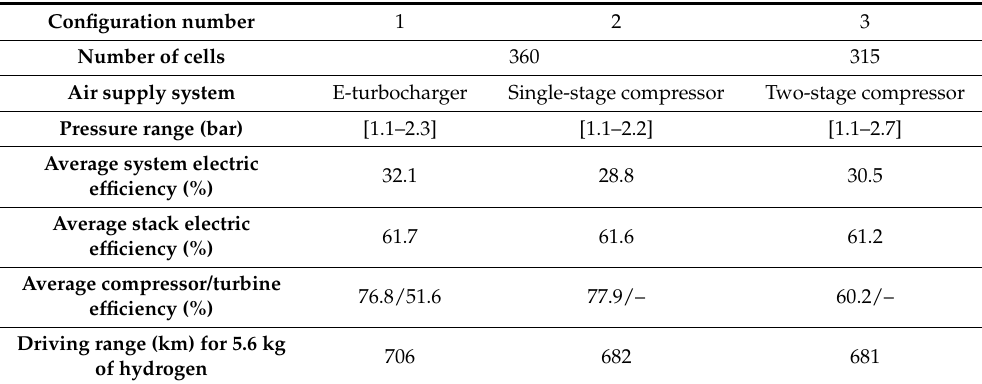
Table 3. Results of the WLTP driving cycle simulation.